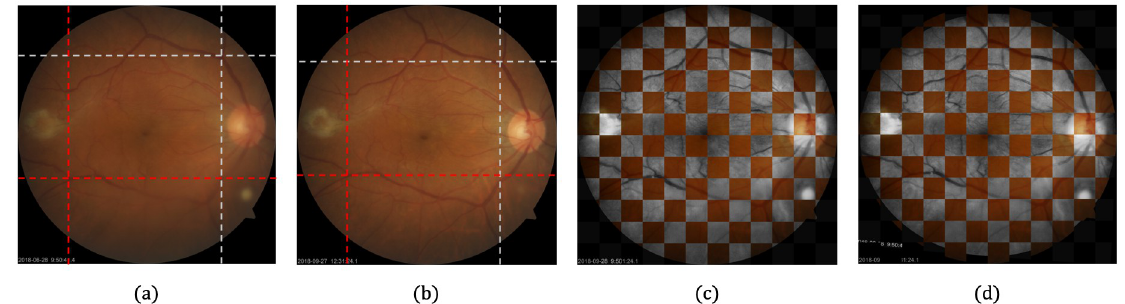
Fig 1. Registration for fundus photograph. (a) Low-quality (LQ) image before registration. (b) High-quality (HQ) image before registration. (c) Checkerboard image before registration with grayscale LQ image and color HQ image. (d) Checkerboard image after registration with grayscale LQ image and color HQ image. The vertical and horizontal dotted lines on (a) and (b) are crossing over singular points (where the blood vessel line diverges) that exist in common in LQ and HQ images.